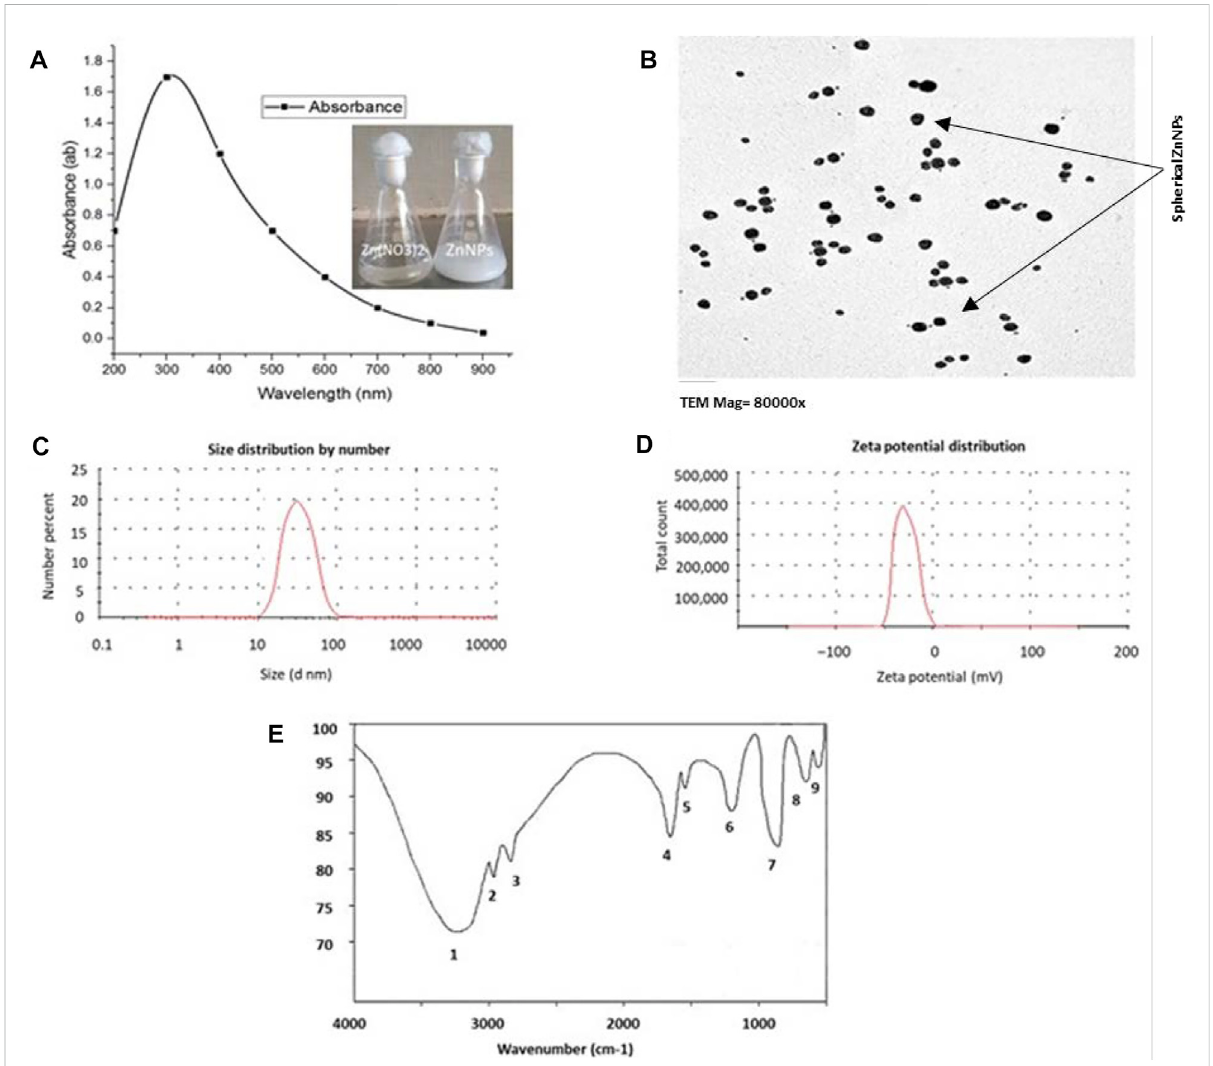
FIGURE 1 Characterization of ZnNPs synthesized by Lactobacillus fermentum TA20. (A) U.V. absorbance at 310 nm, (B) TEM image observes the average sizeofsphericalZnNPs, (C) Exactsizeof51 nmbyZetasizer, (D) SurfacenetnegativechargebyZetapotential(-25.36 mV),and (E) Functionalgroups attached to ZnNPs detected by